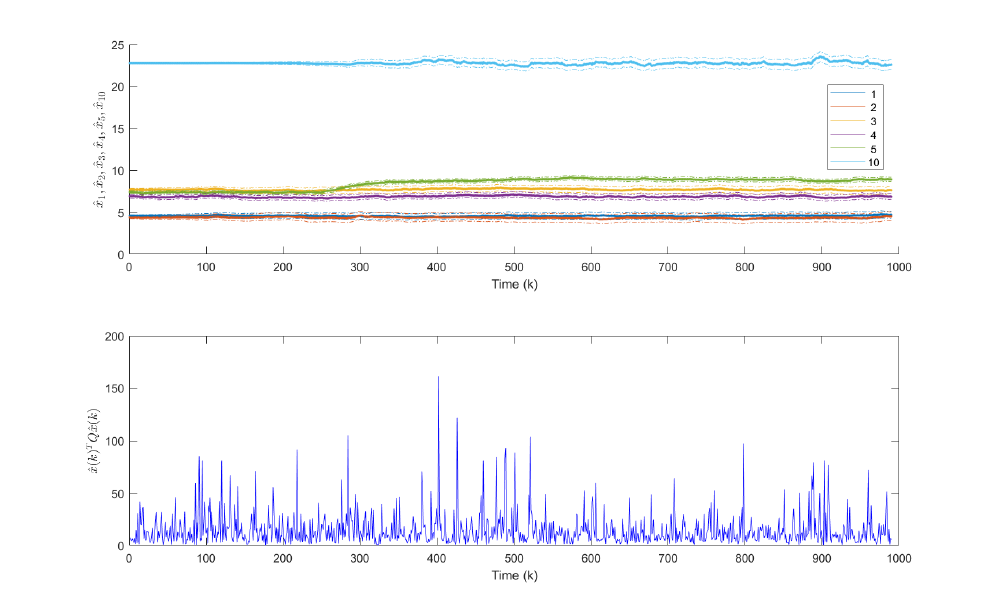
Figure 9. Fault-detection performance at the 2nd workstation. The upper figure illustrates that the algorithm is able to detect operator-dependent problems (after the 250th product). After this change the related to these